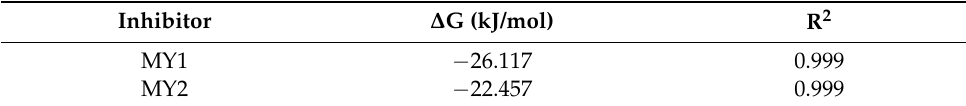
Figure 8. Langmuir adsorption isotherm. Table 4. Thermodynamic adsorption